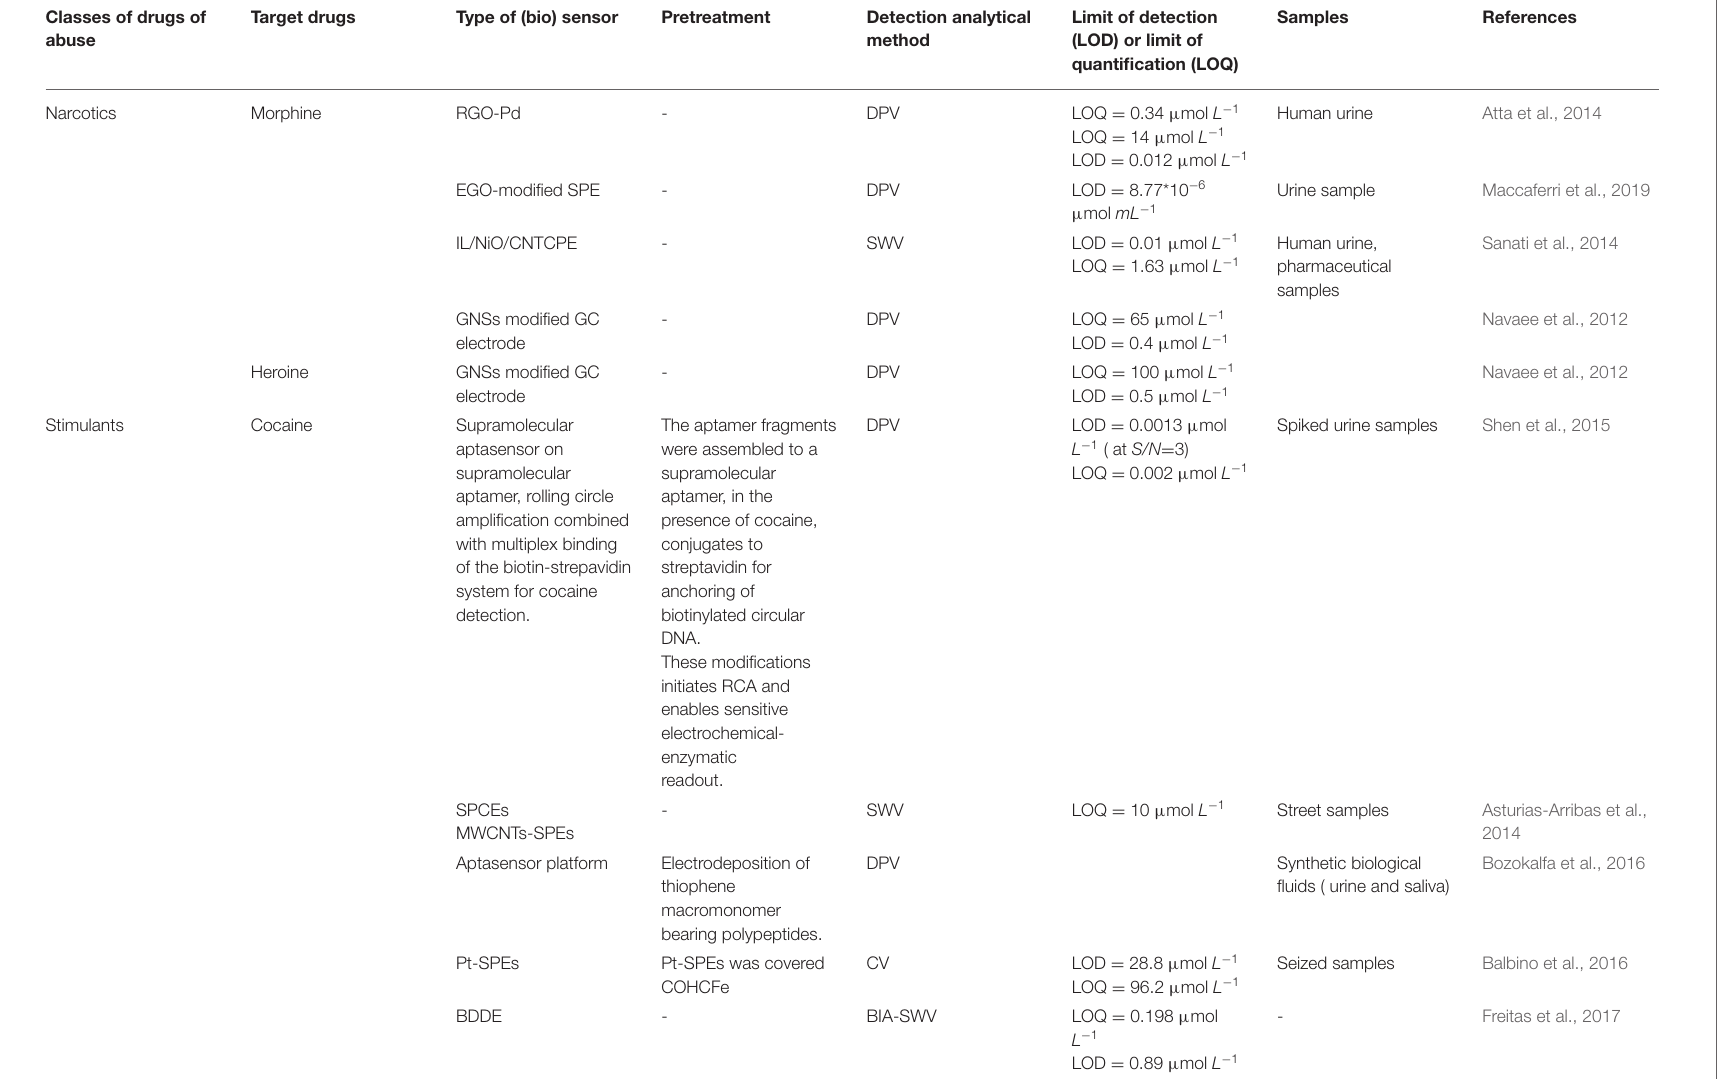
TABLE 1 | Overview list of (bio)sensors for detection of abused